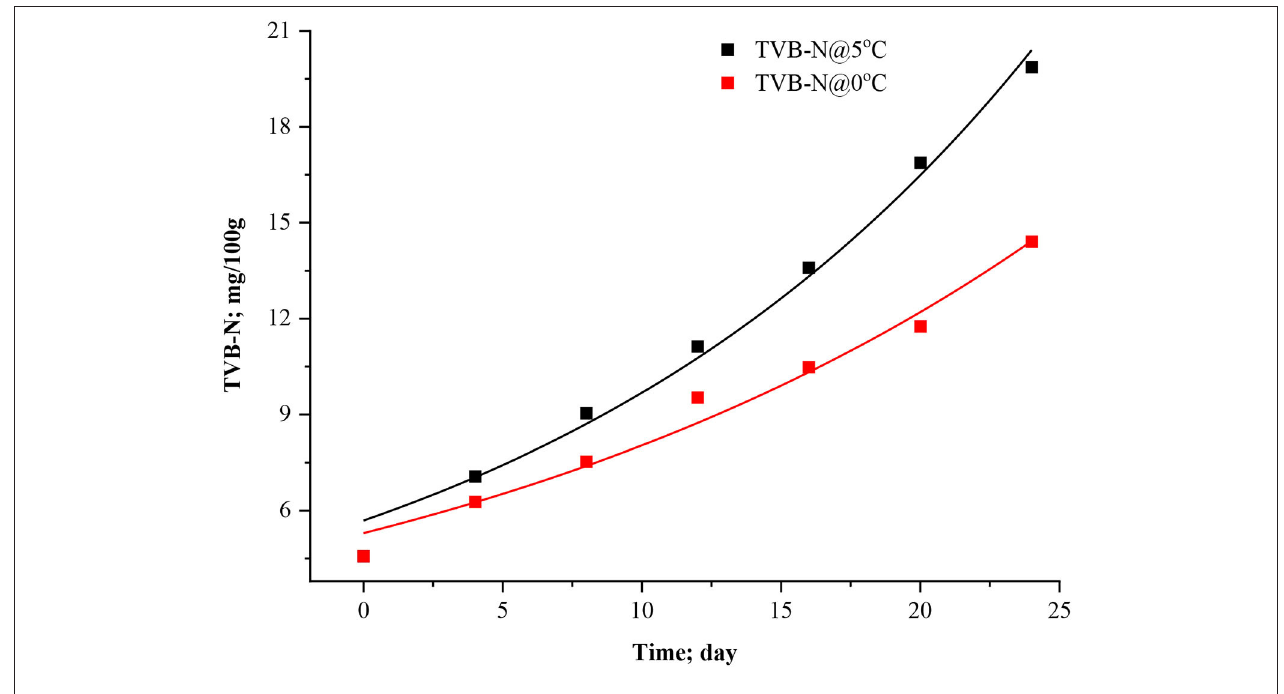
FIGURE 1 | Exponential model curve for TVB-N in stored Rohu fish.